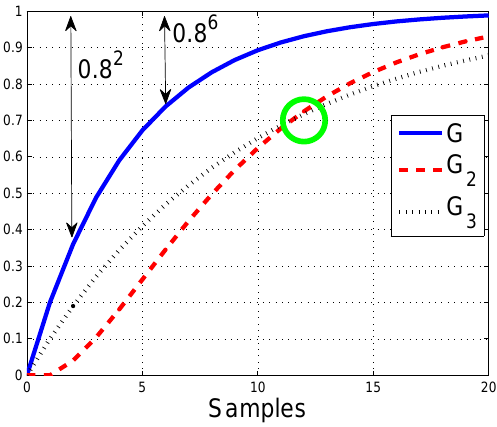
Figure 8. Target first order step response with poles of 0.8 and 0.9 overlaid with a step response of a second order